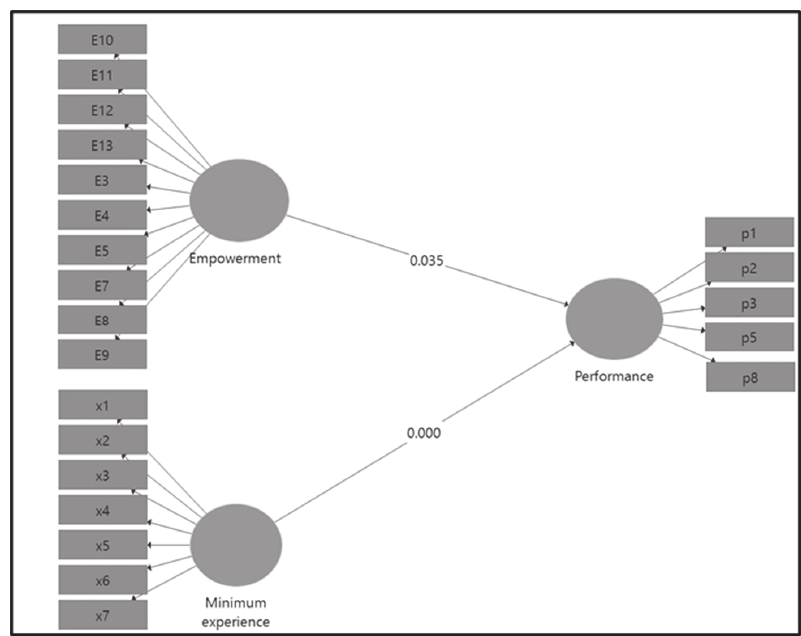
Fig. 2. The results of P-values (R 2 = 0.389)